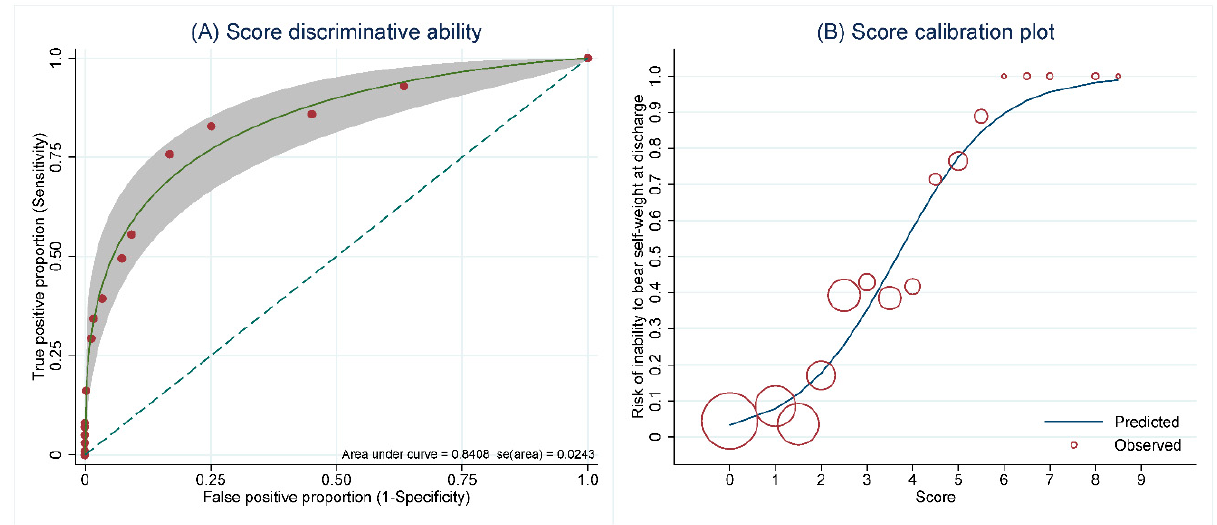
Figure 2. Apparent validation of score performance in terms of discrimination and calibration. ( A )